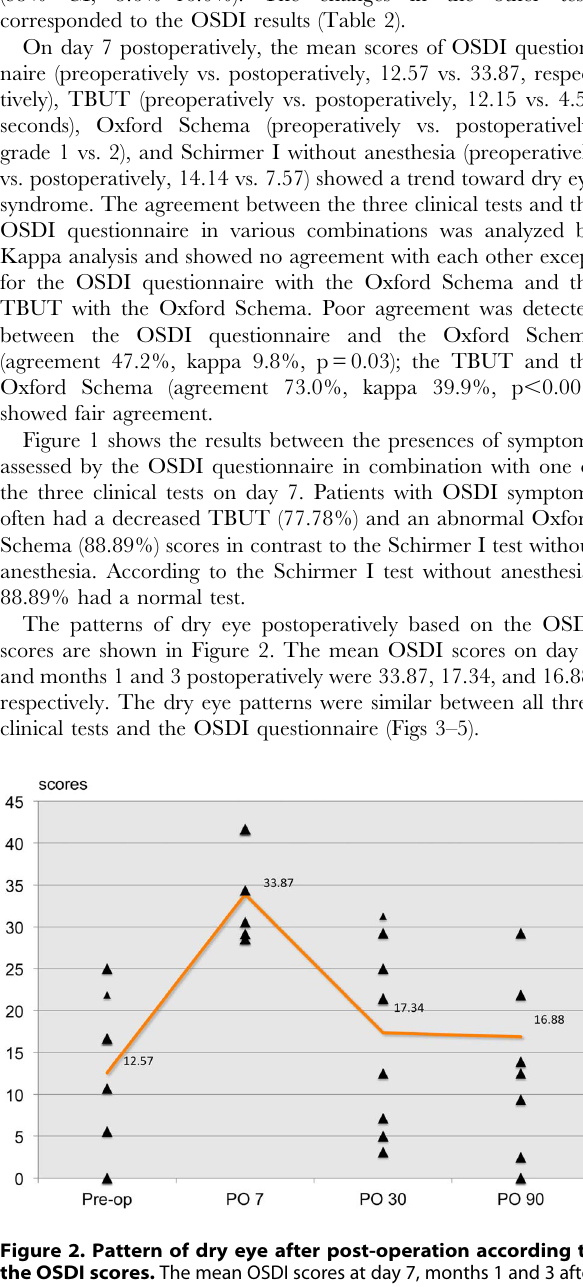
Figure 4. Pattern of post-operative dry eye patients detected by Oxford ocular surface staining system.